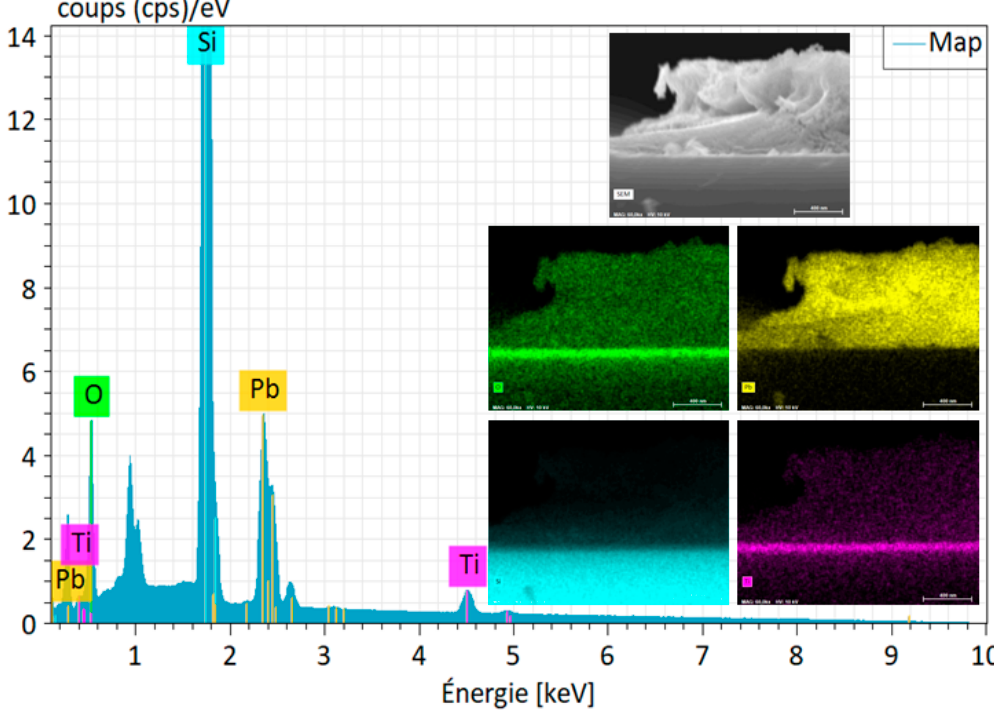
Figure 4. EDX analysis of Si/TiO 2 /PbO 2 electrode in cross-section.